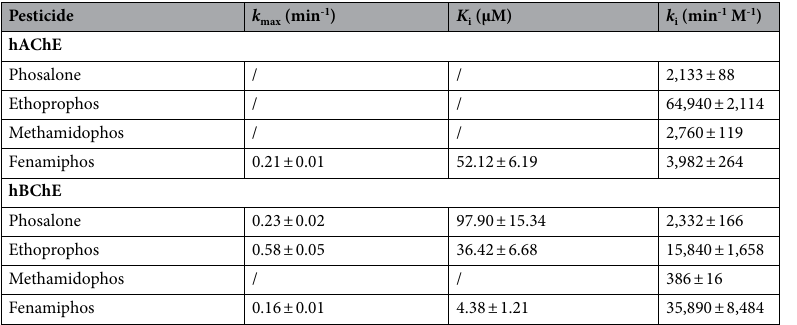
Table 1. Constants (± SEM) for inhibition of human acetylcholinesterase (hAChE) and human butyrylcholinesterase (hBChE) by selected pesticides. The first-order inhibition constant ( k max ), enzyme- inhibitor equilibrium dissociation constant ( K i ) and the overall second-order rate constant of inhibition ( k i ) were determined from k obs constants obtained from at least three experiments at 25 °C.